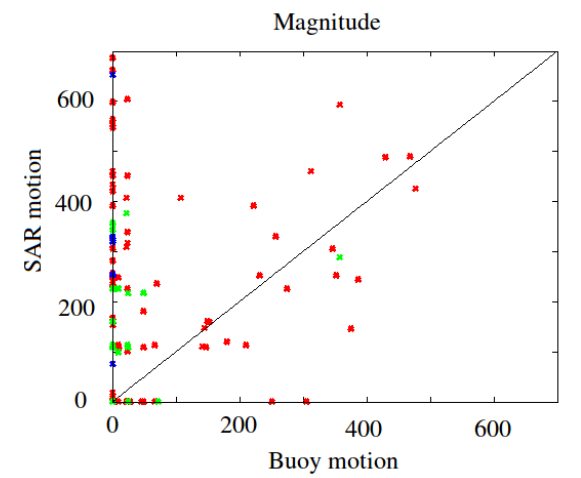
Fig. 10. Magnitude of the buoy drift and estimated ice drift for the short drift data in meters. The different quality classes are indicated by colors ( Q s = 2 → red, Q s = 3 → green, Q s = 4 →